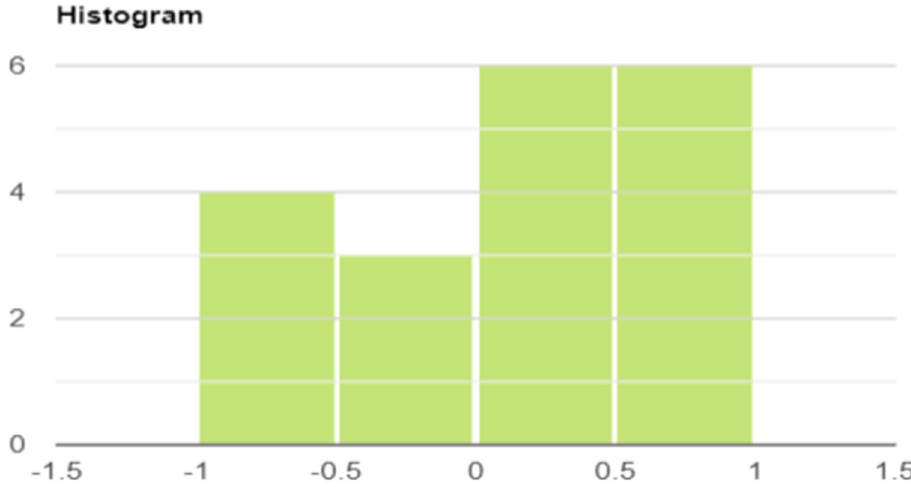
Figure 3. Clusters of real interest rates influence the government debt ratio. Note: the number of member states on the y-axis and the four clusters [ − 1.0; 1.0] on the x-axis are based on the correlation coefficients.